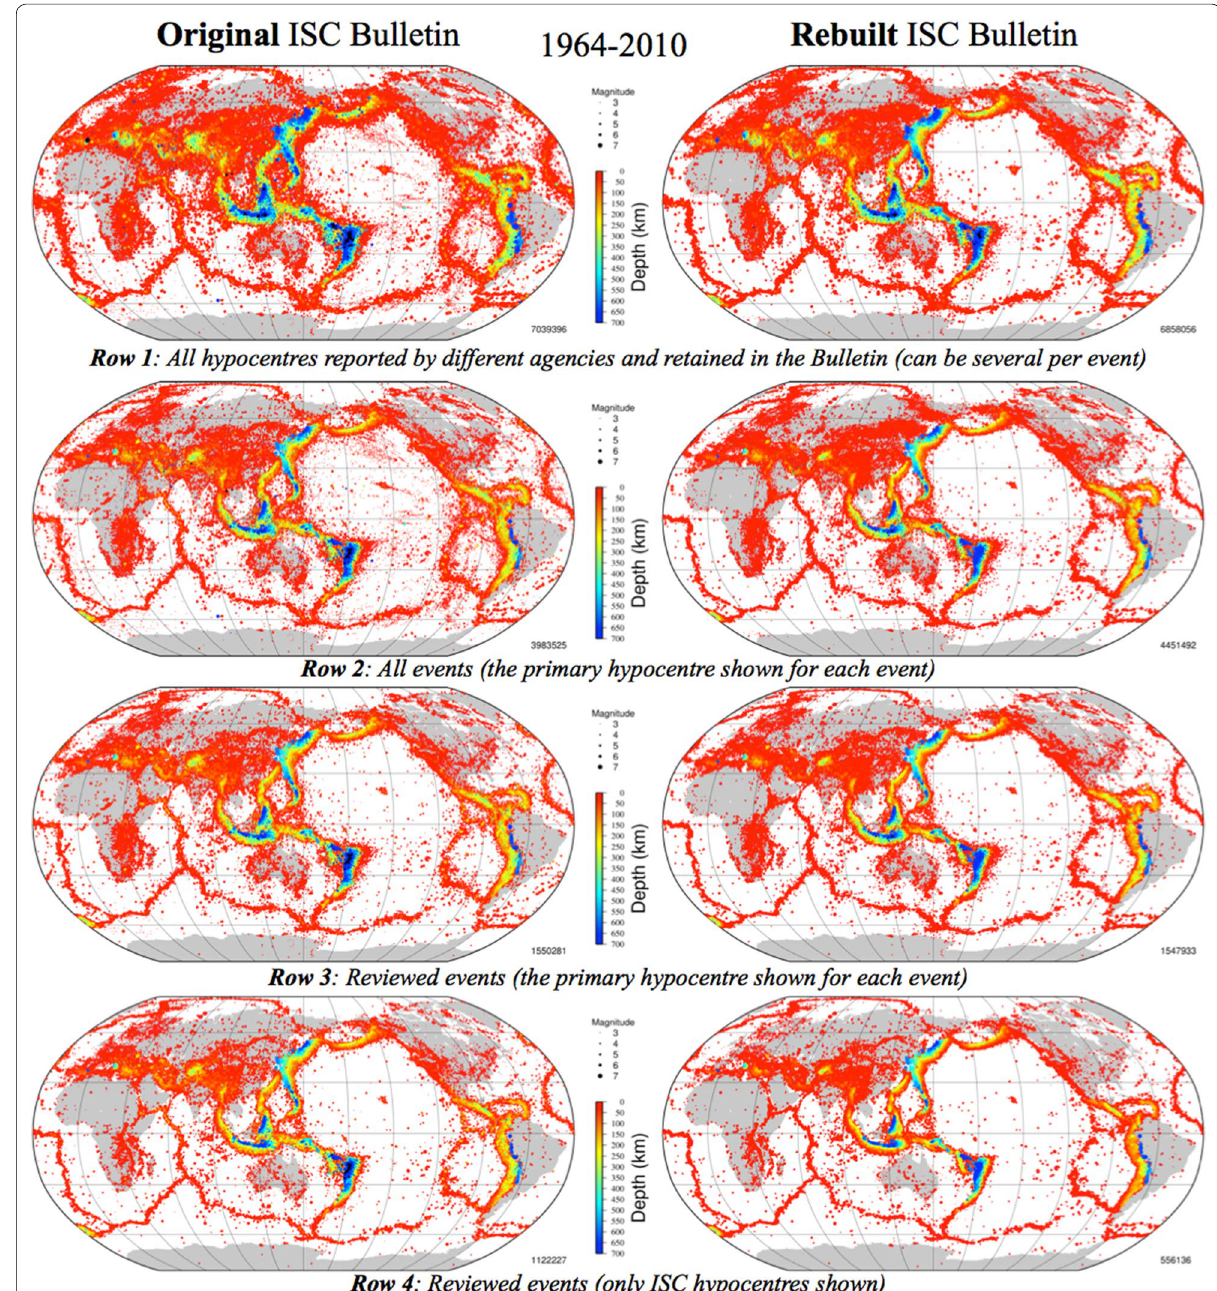
Fig. 9 Global distribution of earthquakes and other seismic events in the ISC Bulletin during 1964–2010 period before (left) and after the Rebuild project (right); individual rows show all and primary hypocentres in the entire Bulletin as well as in its reviewed